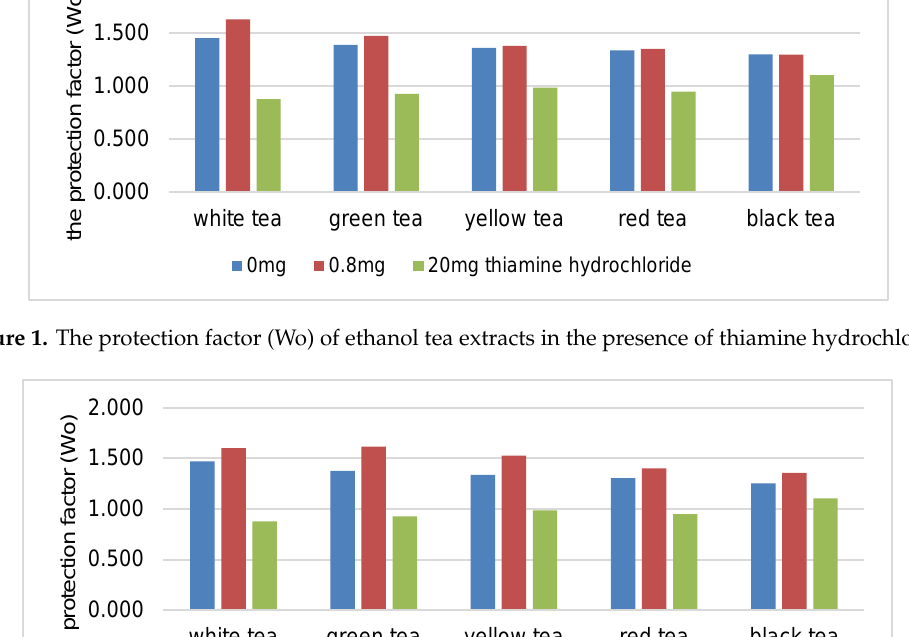
Table 3. Correlation coefficients between the chelating activity and the reducing power of ethanol tea extracts and the content of thiamine pyrophosphate and thiamine pyrophosphate.